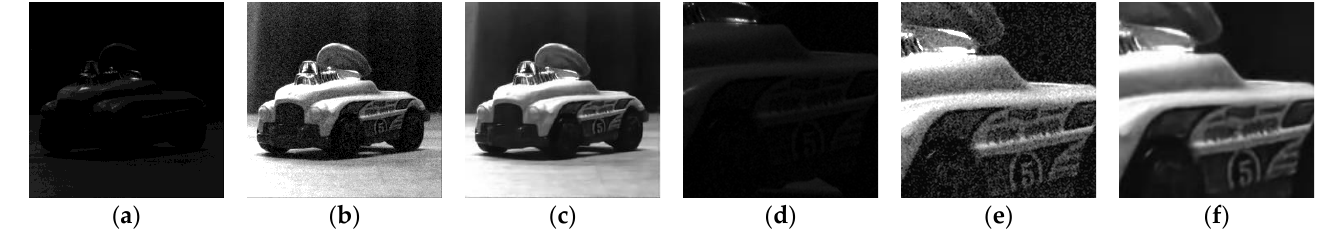
Figure 7. Grey level image enhancement. ( a ) image acquired at low exposure; ( b ) LIP enhancement of ( a ); ( c ) CNN denoising applied on ( b ); ( d ) zoom on ( a ); ( e ) zoom on ( b ); ( f ) zoom on ( c ).